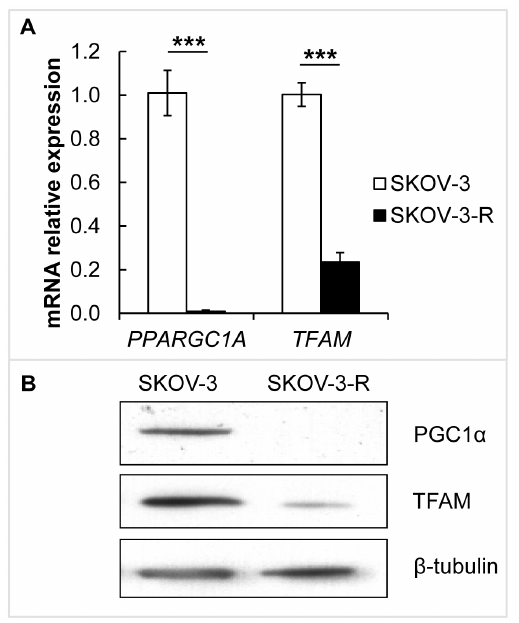
Figure 1. PGC1 a and TFAM expression in EOC SKOV-3 cells and the multiresistant subline SKOV-3-R. (A) Gene expression of PPARGC1A and TFAM in SKOV-3 and SKOV-3-R cells was evaluated by qRT-PCR ( n =3). The decrease in expression in SKOV-3-R was statistically significant (both p , 0.001, using independent t-test). Expression levels were normalised to ACTB . Error bars represent S.E.M. (B) Representative western blot showing protein expression of PGC1 a and TFAM. b -tubulin was used as loading control.